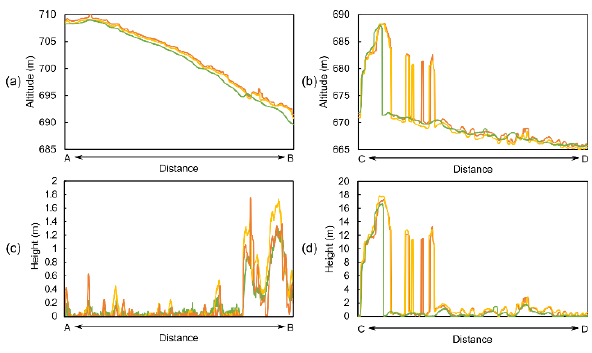
Figure 2. Orthophoto mosaic of the whole study area. Coloured rectangles represent the various flights carried out for different purposes. The numbers refer to: (1) logging operations; (2) trees that were not affected by the fire; and (3) agricultural fields. Lines A-B and C-D represent the profile lines used in this study.